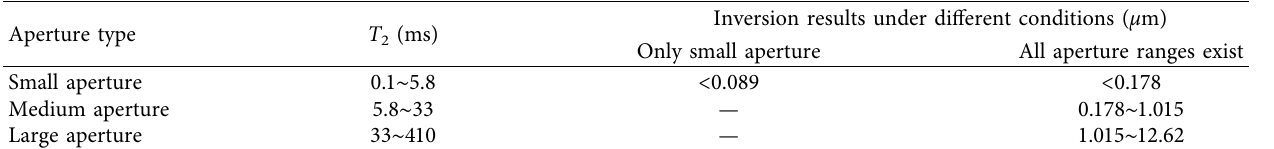
Figure 8: Pore size distribution during freezing. Table 2: T 2 value and pore size of different